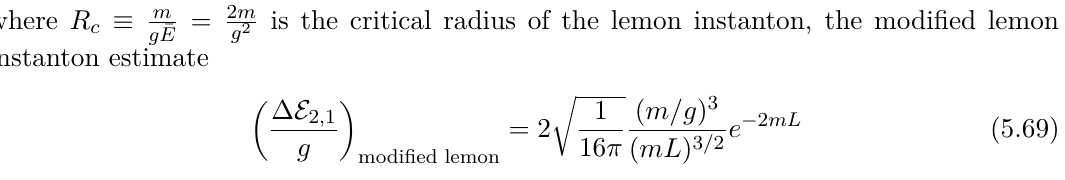
Figure 16. The continuum extrapolated ( N/ modified lemon instanton estimate (5.69) (curves) of the energy difference ∆ E second and first excited states for background field α = 0 . Top panel: each color represents a fixed value of m/g ; bottom panel: each color represents a fixed value of mL